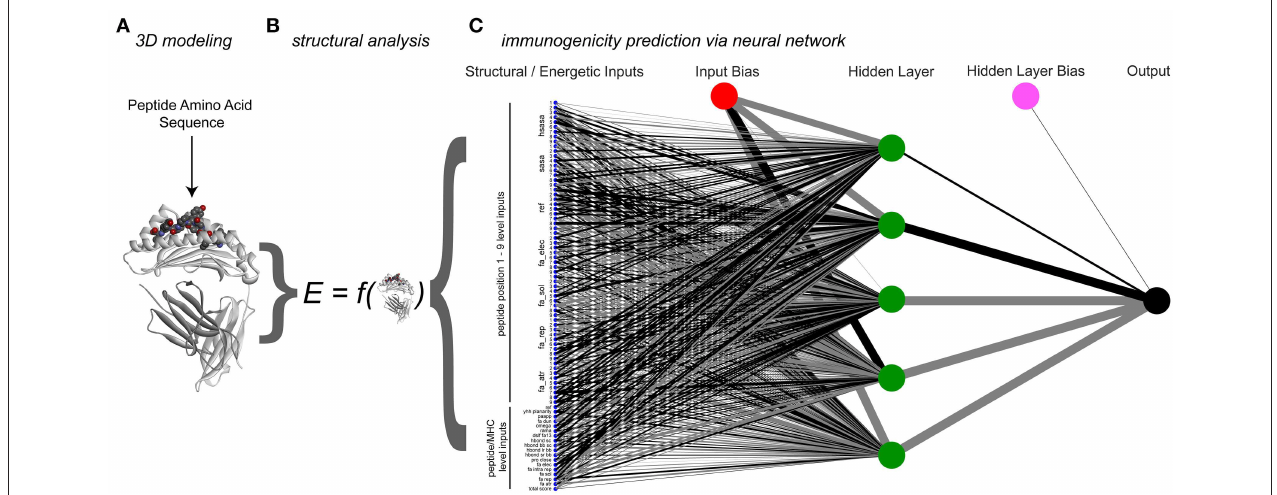
FIGURE 4 | Process and architecture of the structure-based immunogenicity neural network. (A) The process begins with a peptide sequence, which is used to generate a model of the peptide/HLA-A2 three-dimensional structure. (B) Analysis of the modeled structure yields energetic and topographical information, which are used as inputs for the structure-based immunogenicity neural network. (C) Trained neural network architecture, with 81 structure-derived inputs shown on the left (seven for each peptide position, 18 for the overall complex). A single hidden layer is present with five hidden neurons, along with two constant bias nodes. Black lines give positive weights, gray lines negative weights, with line width indicating weight magnitude.